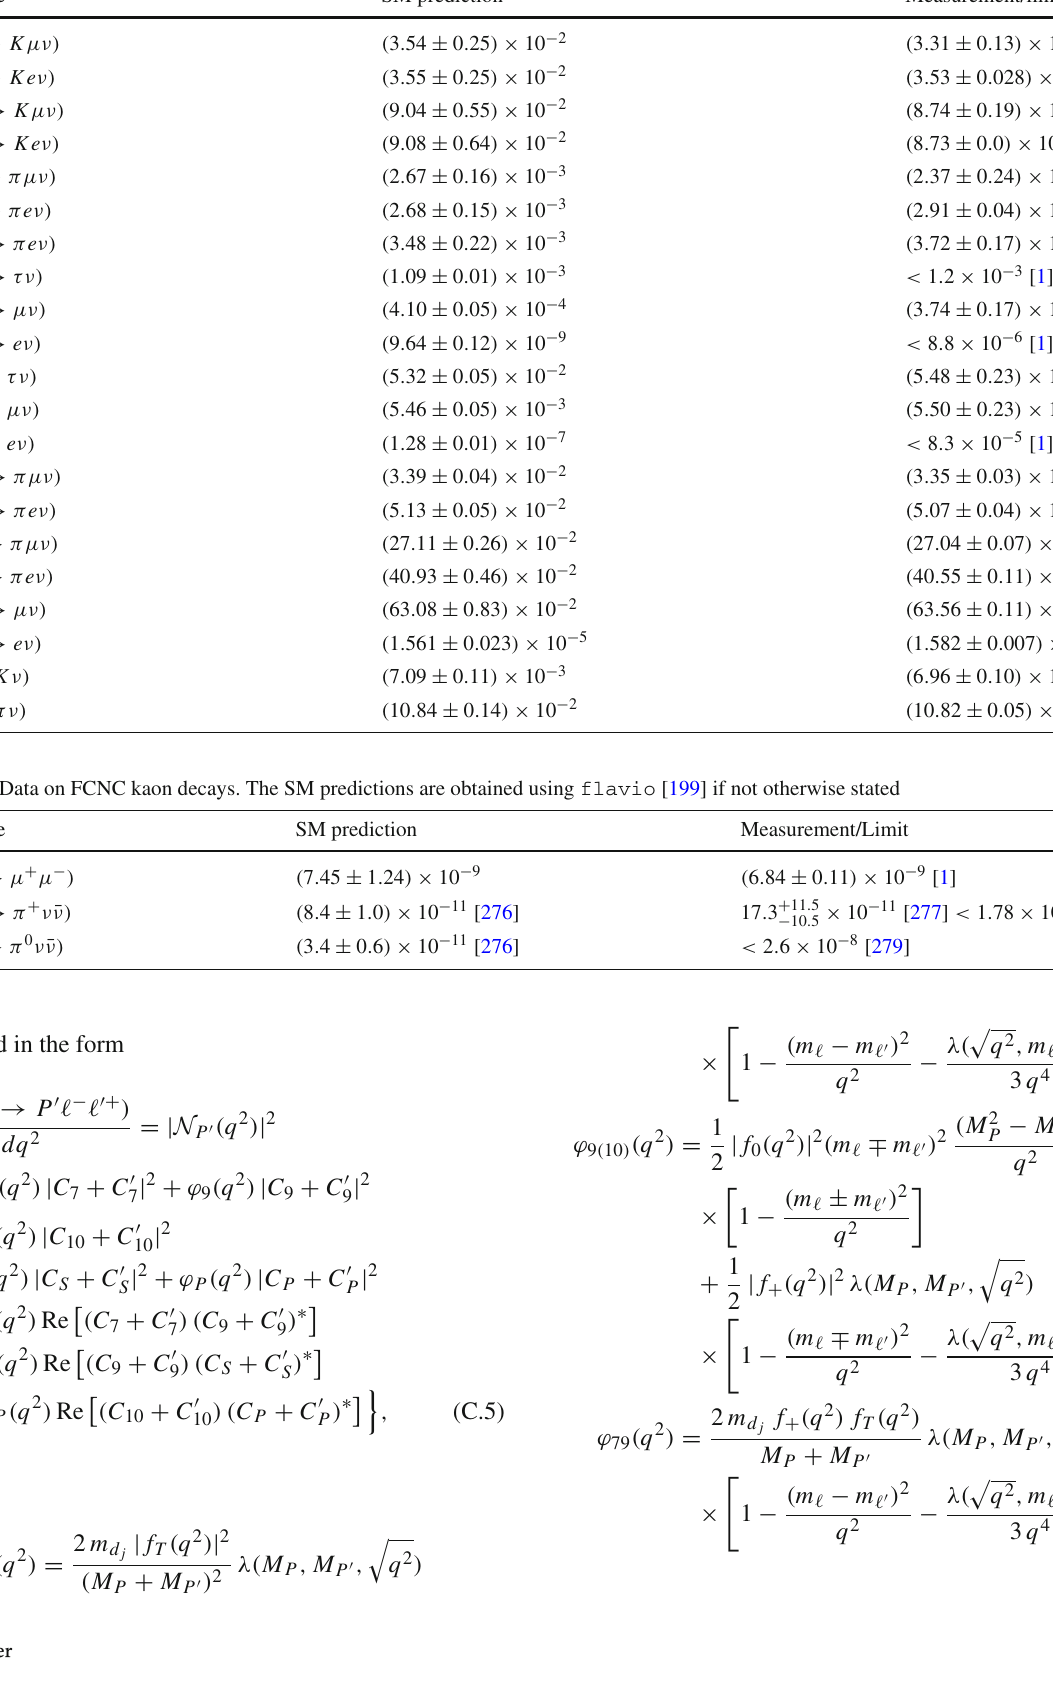
Table 12 Data on charged current charm and strange flavoured meson decays. The SM predictions are obtained using flavio [199] Observable